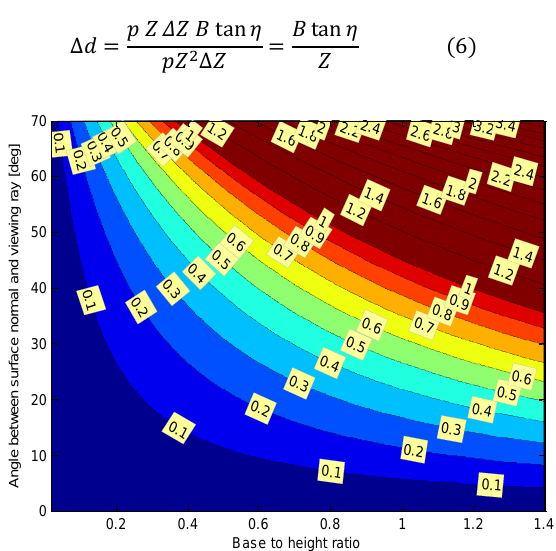
Figure 9: Relation between base/height ratio, angle between surface normal and viewing ray and the resulting disparity shift. If the shift becomes large, e.g. greater than 1 pixel, the matching becomes more difficult and can fail. Thus, very base to height ratio should be avoided.